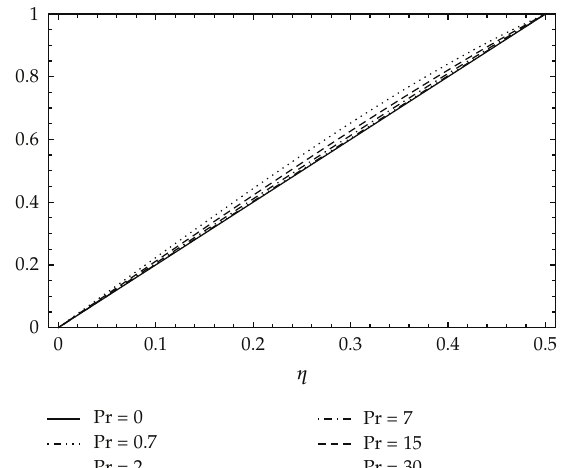
Figure 6: The normalized temperature profiles (cid:3) θ (cid:3) η (cid:4)(cid:4) obtained by the 8th-order approximation of the HPM for di ff erent values of the Prandtl number, when δ (cid:7) 0 . 5.